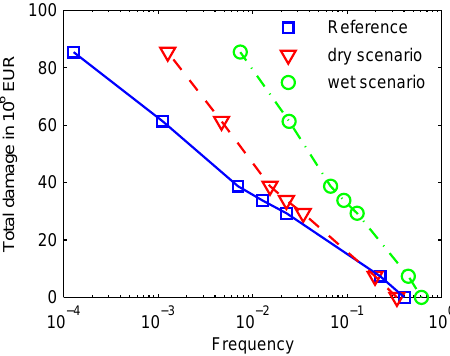
Figure 8. Risk curve in Chaudfontaine (lower reach) in the present situation and in the time period